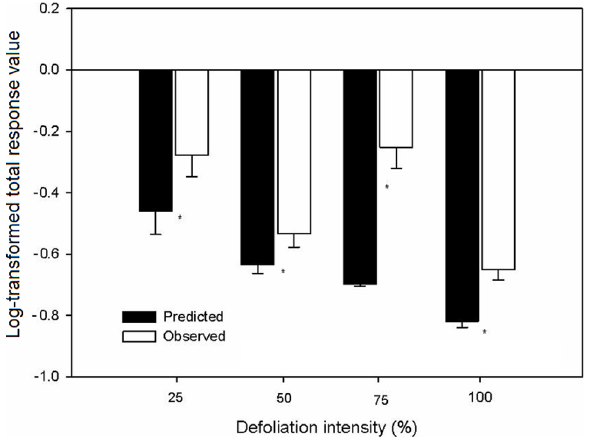
Figure 5. Log-transformed total predicted and observed response values to defoliation and competition of invasive Mikaniamicrantha defoliated at different intensities. Values are means 6 standard deviation. The different lowercase letters indicate a significant difference between the defoliation intensities at p , 0.05. * indicates significant differences ( p , 0.05) between the treatments with or without competitor.